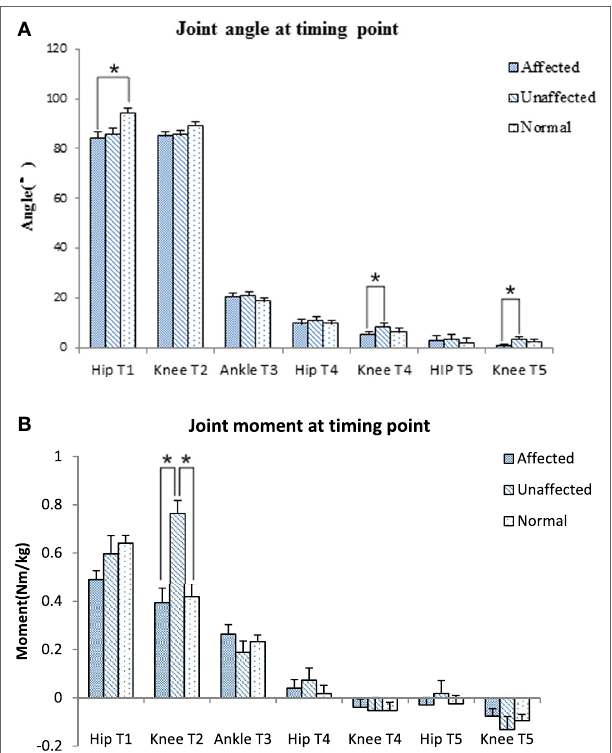
FigUre 5 | Time to maximal joint moment (a) and Maximal joint moment (b) during transitional action among the affected, unaffected side of stroke, and healthy controls (* p <